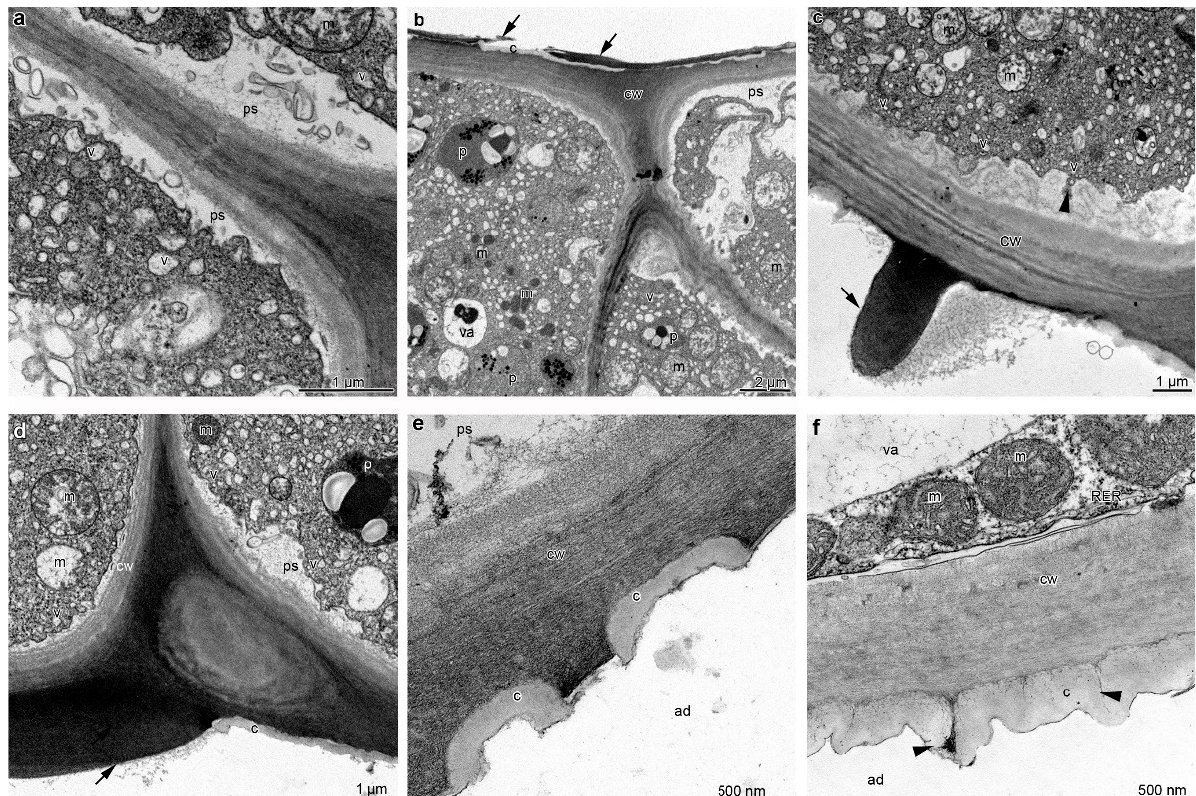
Figure 5. Ultrastructure of the adaxial epidermis of the middle ( a – e ) and lateral ( f ) lobes of the labellum of B. carunculatum (TEM). ( a – c ) Cells with periplasmic space, flocculated secretory material, and numerous vesicles building into plasmalemma ( c , black arrowhead). ( b – e ) Adaxial epidermis with ruptured cuticle and residues of secretion on the surface ( b – d ) (black asterisk). ( f ) Cell wall with a cuticle with microchannels with secretion (black arrowheads). c: Cuticle, cw: cell wall, m: mitochondrion, p: plastid, ps: periplasmic space, va: vacuole, v: vesicle.